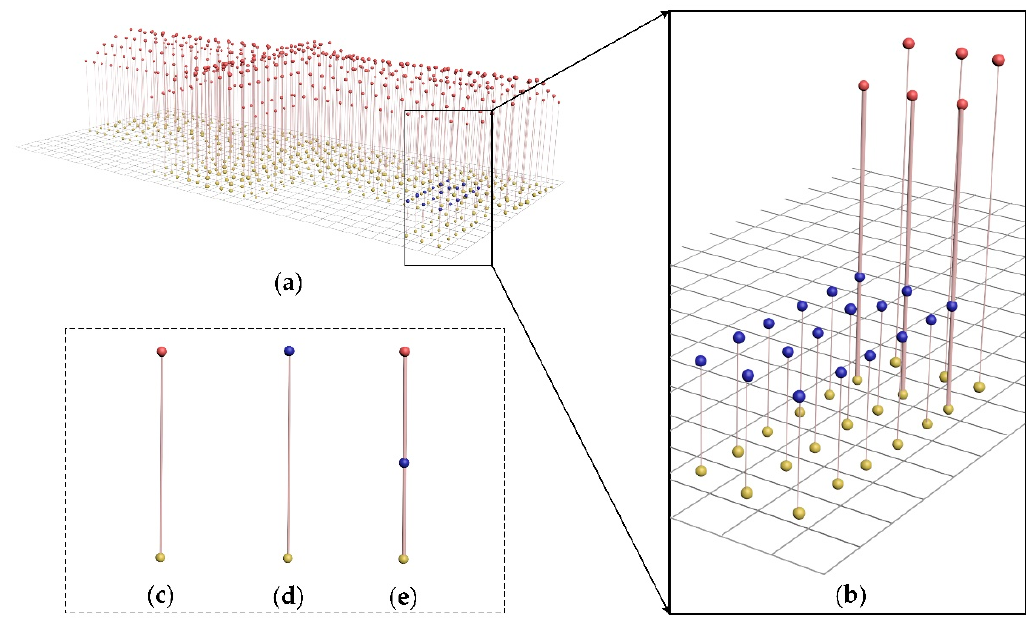
Figure 2. An example of layer-connection points: ( a ) yellow points represent the first layer (ground), blue points represent the second layer, and red points represent the third layer; ( b ) an enlarged view; ( c ); ( d ) lines to connect points from two layers; and ( e ) line to connect points from three layers.